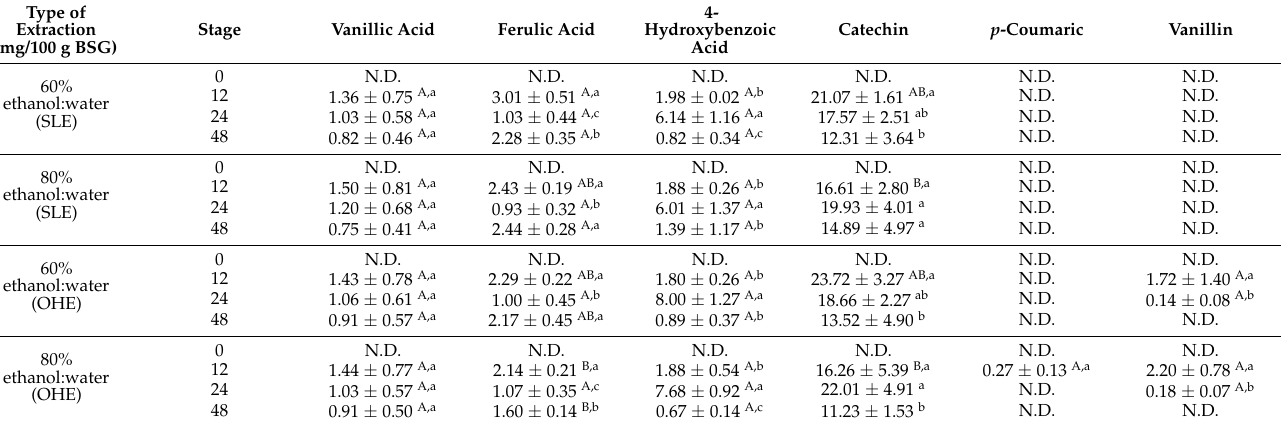
Table 6. Concentration of polyphenols throughout fermentation of BSG flours with human microbiota (mg/100